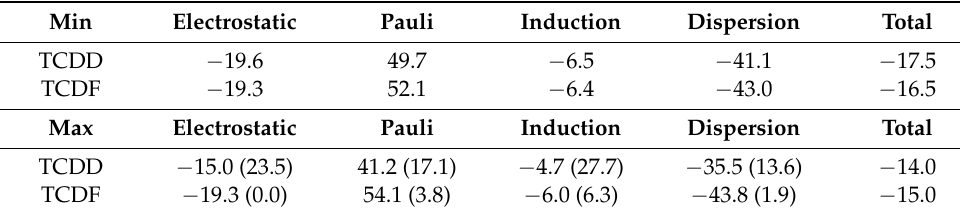
Table 1. Mean values of the interaction energy and its different components at the free energy minima and local maxima of the TCDD and TCDF permeation. The percentage of change with respect to the minimum of the energies at the local maximum is given in